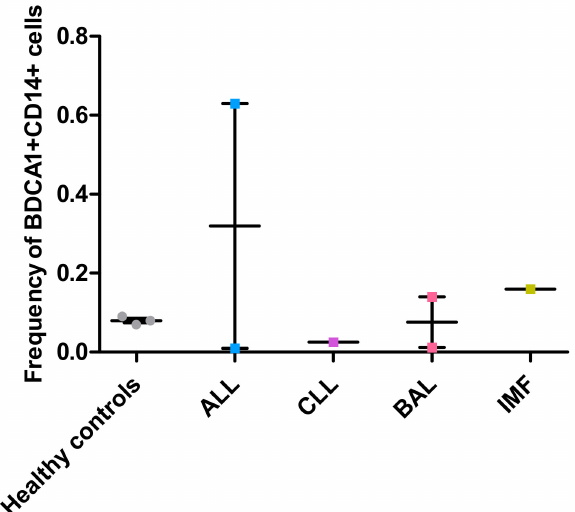
Figure A1. Frequency of BDCA1+CD14+ cells in PBMCs of leukemia patients. Frequency of cells was analyzed by flow cytometry in BMPC of healthy controls and patients with acute lymphoid leukemia (ALL; n = 2), chronic lymphoid leukemia (CLL; n = 1), biphenotypical leukemia (BAL; n = 2) or idiopathic myelofibrosis (IMF; n = 1). Each dot represents PBMCs of a single patient. Mean ± SD.